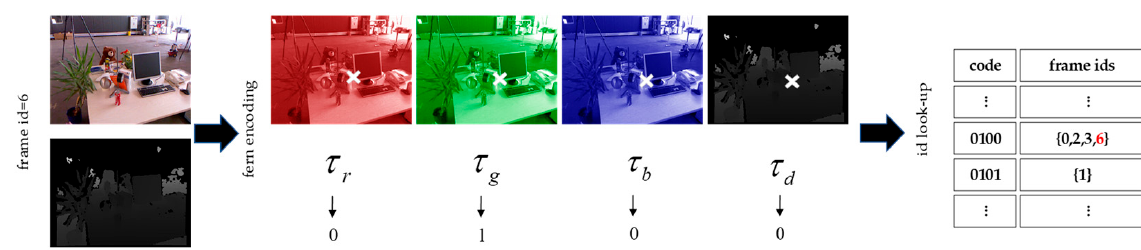
Figure 2. Random fern coding schematic.